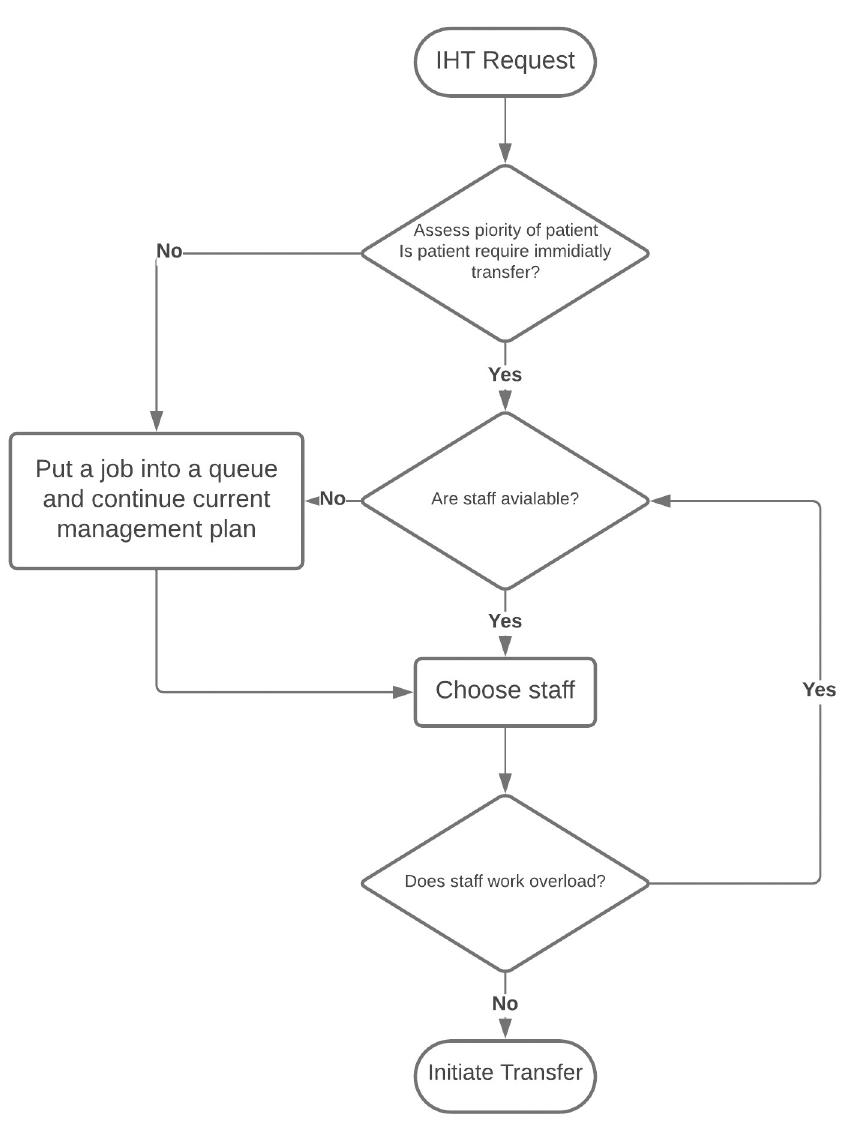
Fig 2. Intra-hospital patient transfer